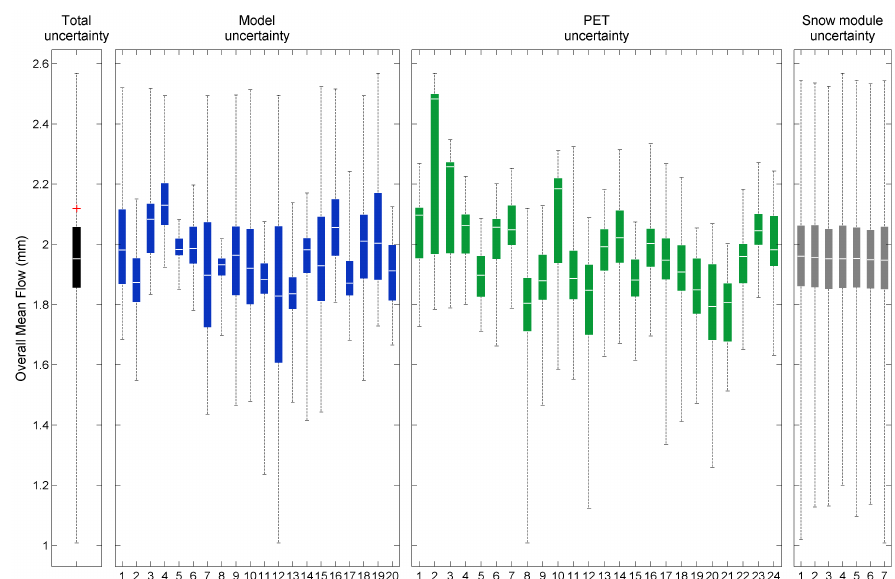
Figure 8. Total (black box plot) and process-based overall mean flow (OMF, mm) uncertainty, for simulation on the observed period. The observed OMF is illustrated by a red cross in the total uncertainty box. Blue box plots correspond to the lumped conceptual hydrological models, green box plots to the PET formulations and grey box plots to the snow modules.